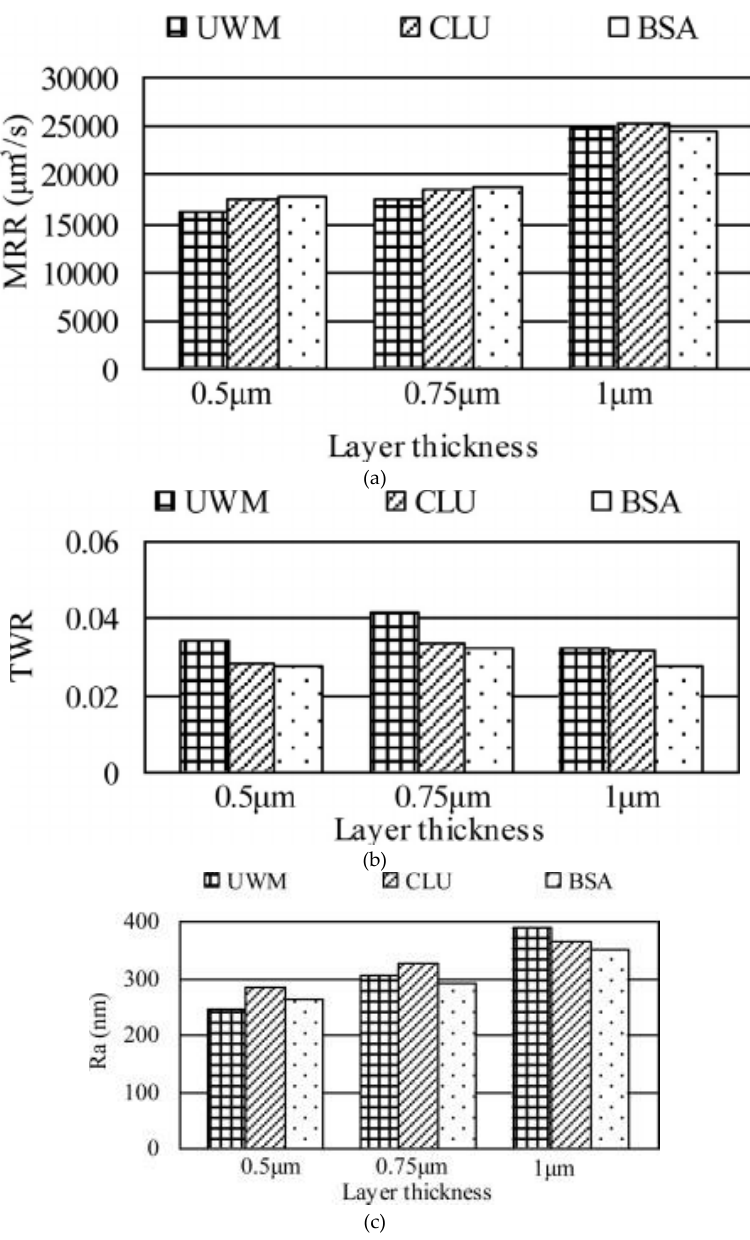
Figure 21. ( a ) MRRs for the three methods UWM. CLU and BSA; ( b ) TWRs for the three methods; and ( c ) SR for the three methods [167].